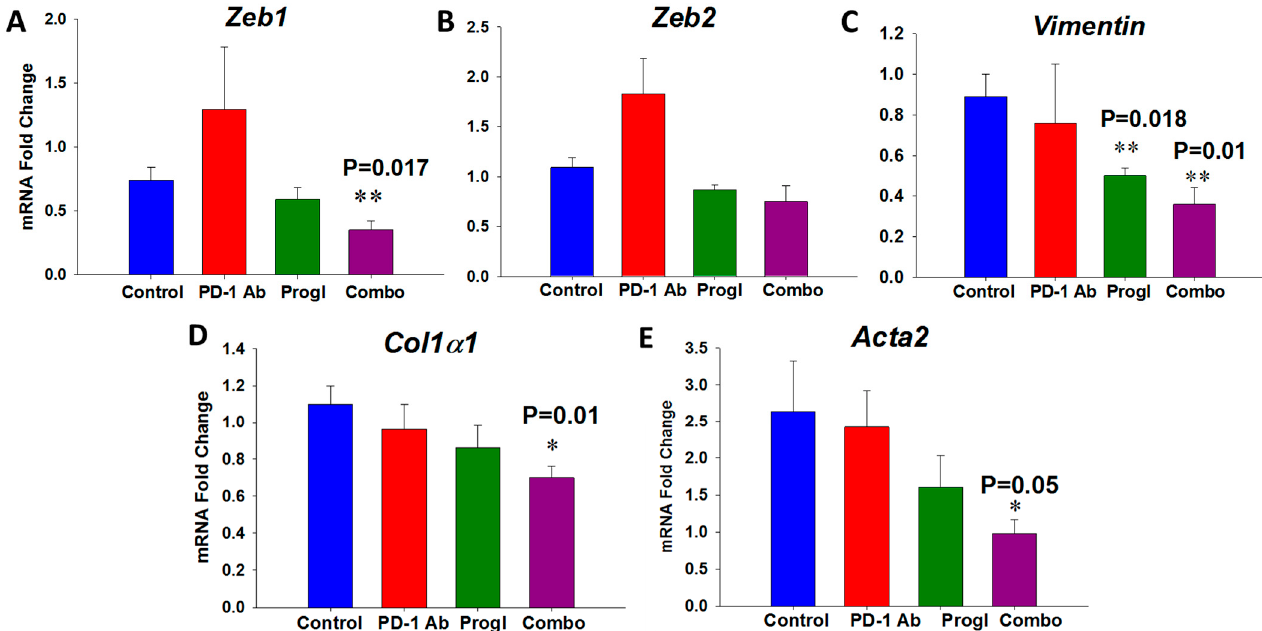
Figure 4. Evaluation of selective genes from all four groups of RIL-175 tumors involved in epithelial-to-mesenchymal transition (EMT) and fibrosis. ( A – C ) mRNA fold change by qRT-PCR of genes involved in EMT shows that mice treated with the combination (Combo) had significantly decreased expression of ( A ) Zeb1 ; ( B ) Zeb2 ; and ( C ) Vimentin. ( D ) Expression of Col1 α 1 that codes for collagen- α 1 is significantly decreased in tumors of mice treated with the Combo therapy. ( E ) Expression of Acta2 , the gene that codes for α -smooth muscle actin from activated fibroblasts, was also significantly decreased in tumors of mice treated with Combo.